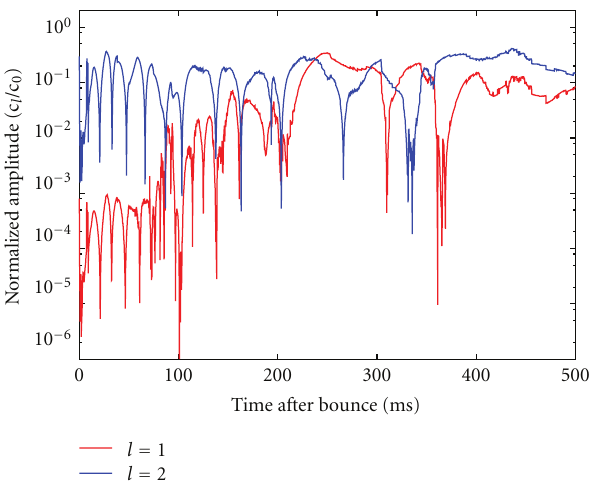
Figure 3: SASI activity for the rotating model versus postbounce time. Shown are the coe ffi cients of the dipole ( (cid:3) = 1) and quadrupole ( (cid:3) = 2) modes of the spherical harmonics of the aspherical shock position, normalized to the amplitude of the (cid:3) = 0 mode (taken from